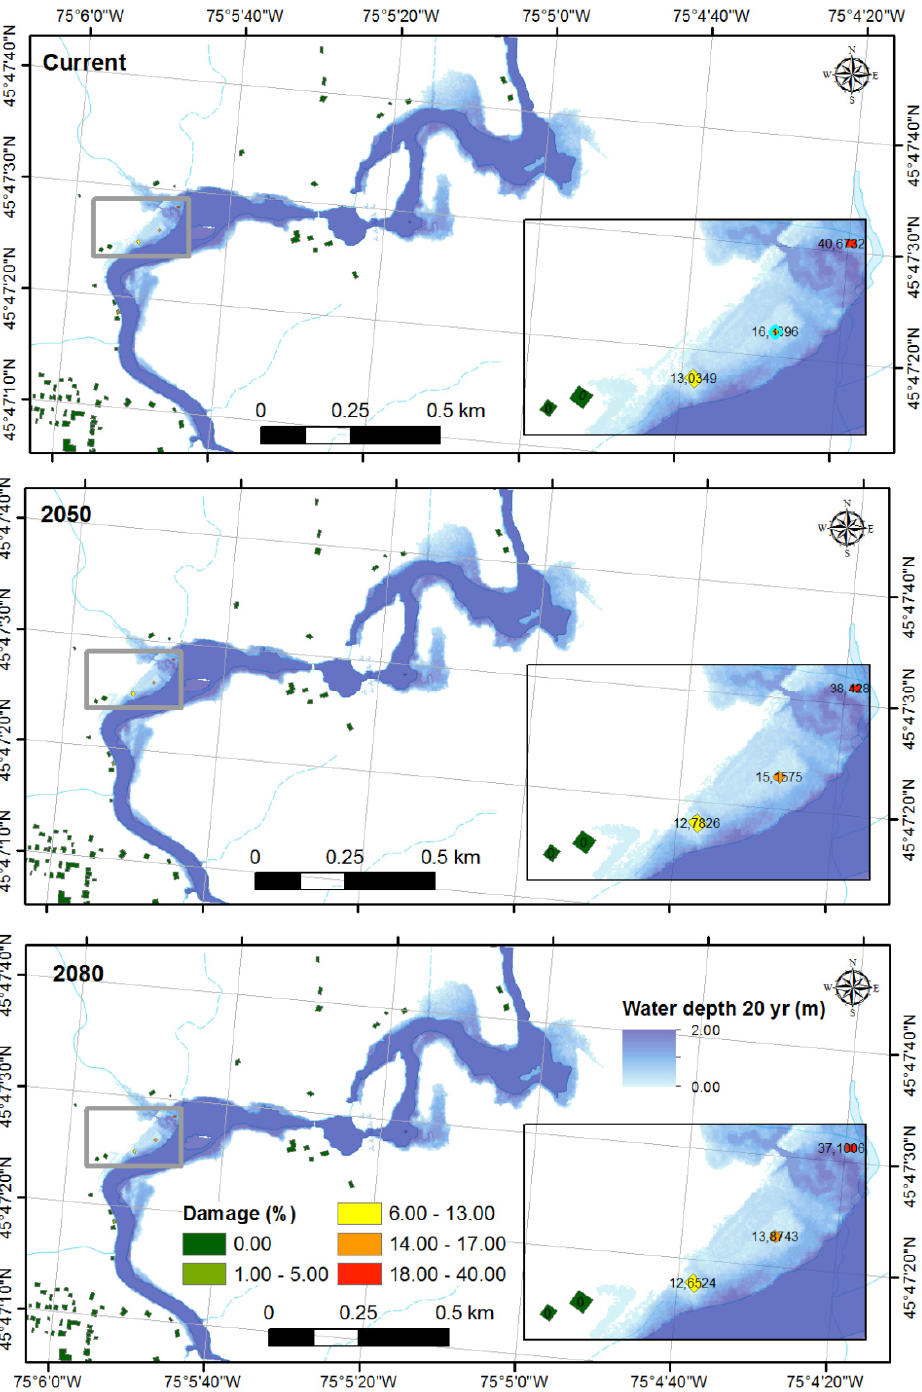
Figure A9. Projected monetary damage map expressed in percentage for a 20-year return period with current, 2050, and 2080 (RCP 8.5). Case: Ripon.